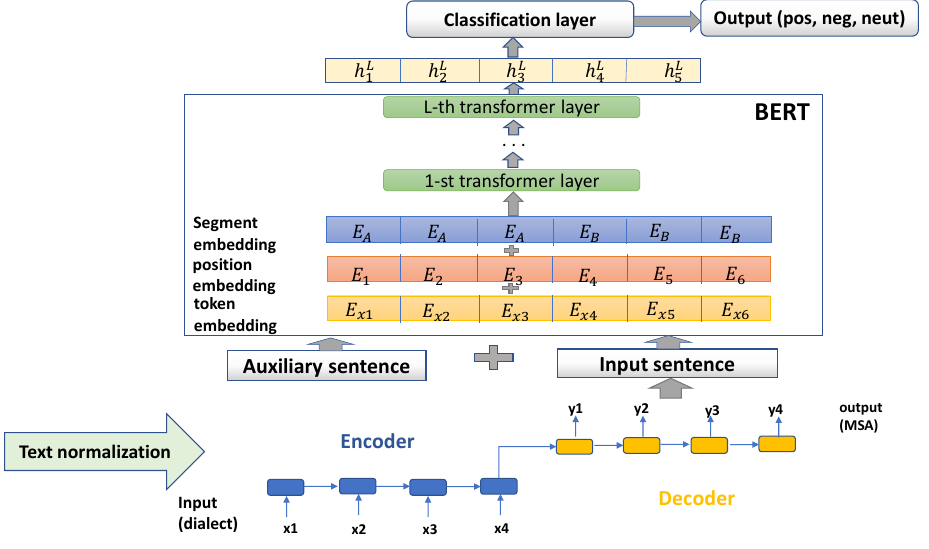
Figure 4. The architecture of the proposed model.